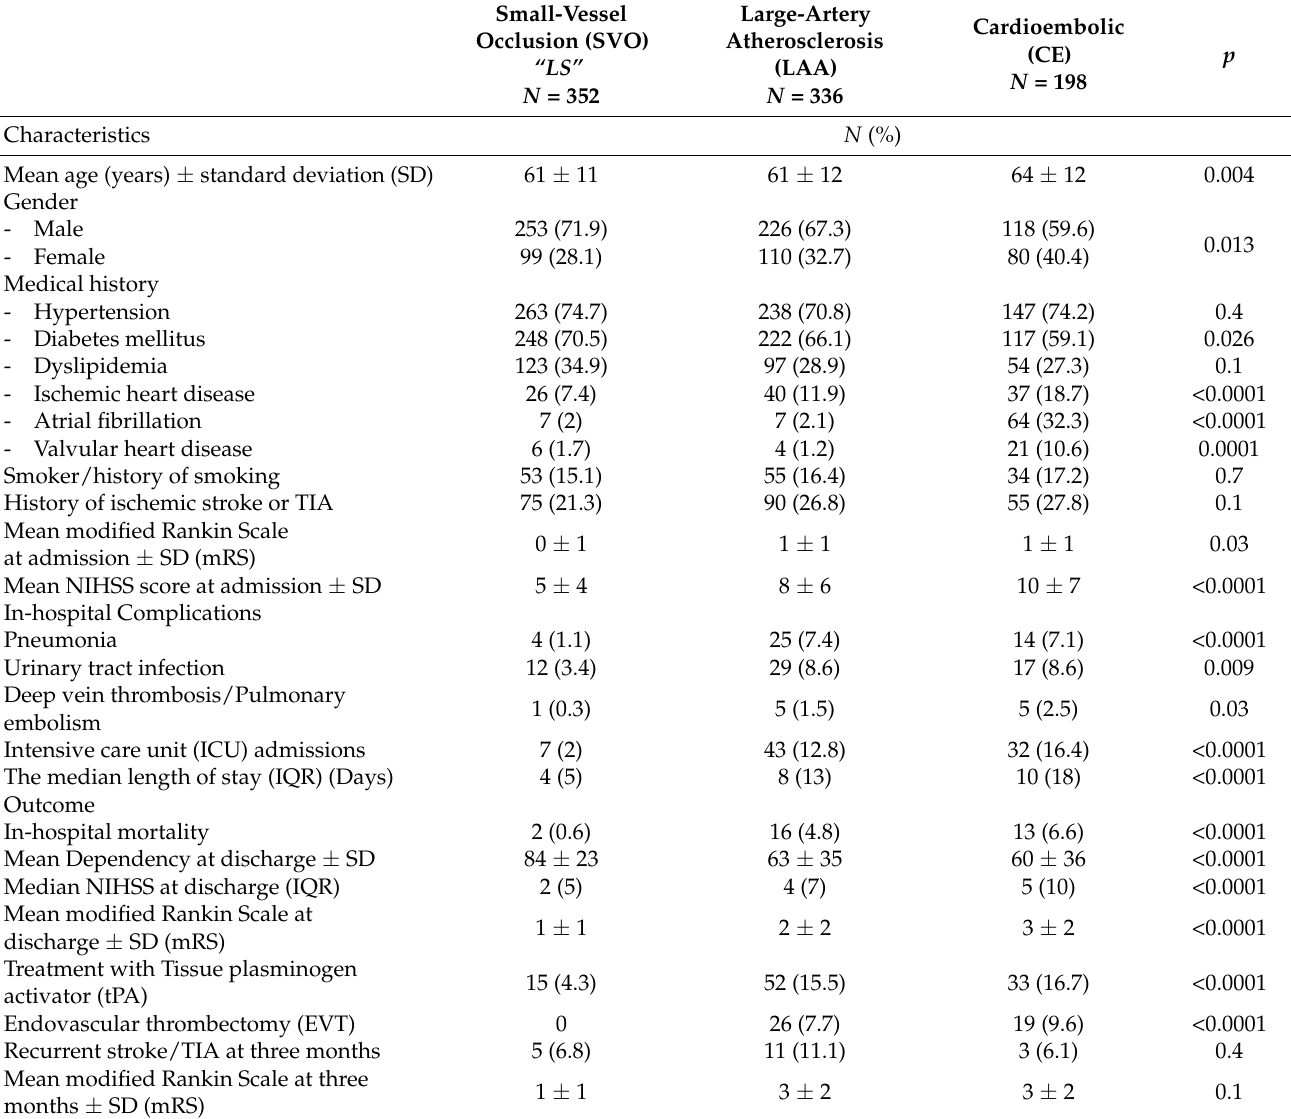
Table 2. A comparison of LS patients and other ischemic stroke based on TOAST